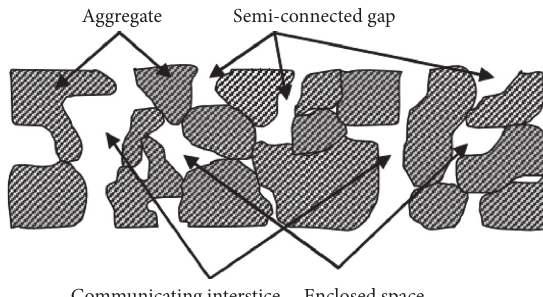
Figure 8: Gaps of drained asphalt